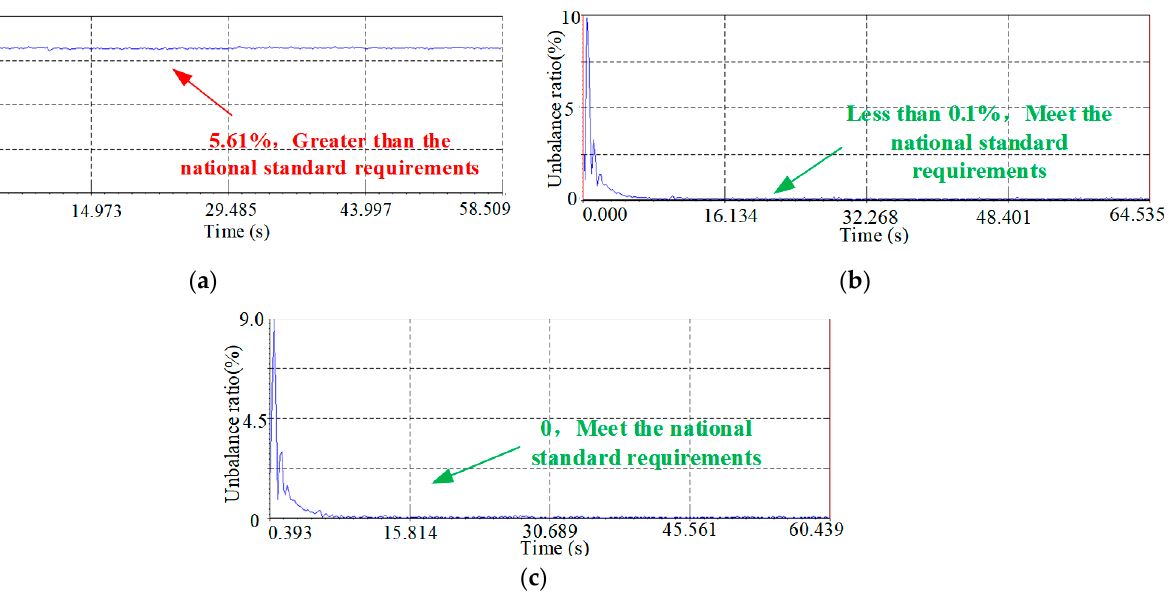
Figure 11. Experimental results for the waveform of imbalances ratio ( a ) with the traditional PI control strategy; ( b ) with the harmonic and imbalance voltage suppression of multi-inverter parallel VSG; ( c ) with the harmonic and imbalance voltage suppression of multi-inverter parallel VSG adding a secondary control strategy.